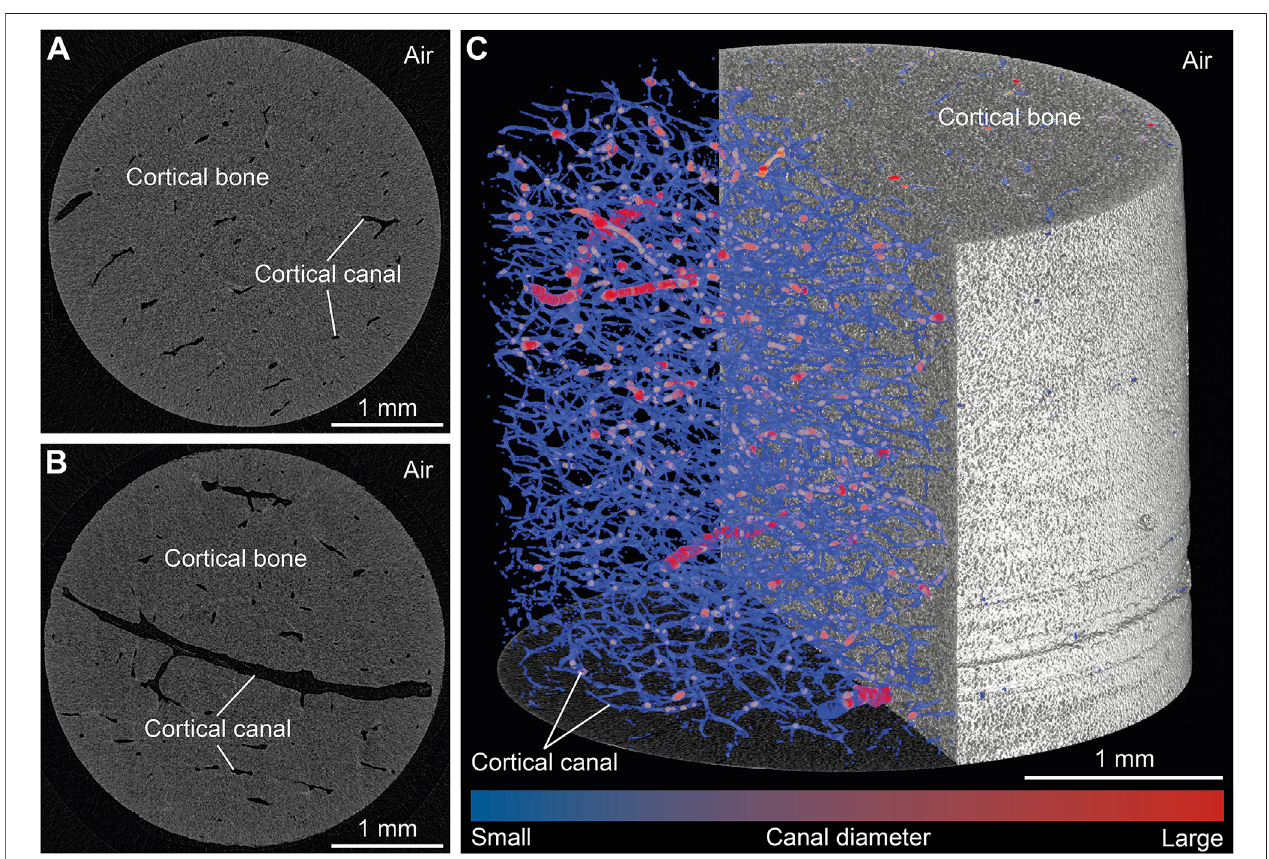
FIGURE 2 | Visualization of representative results from micro-computed tomography scans of pristine cortical bone samples obtained with 3 µm isotropic voxel resolution. (A,B) Two selected virtual sections oriented perpendicular to the growth direction. (C) Volume rendering of a selected sample and its cortical canal network.